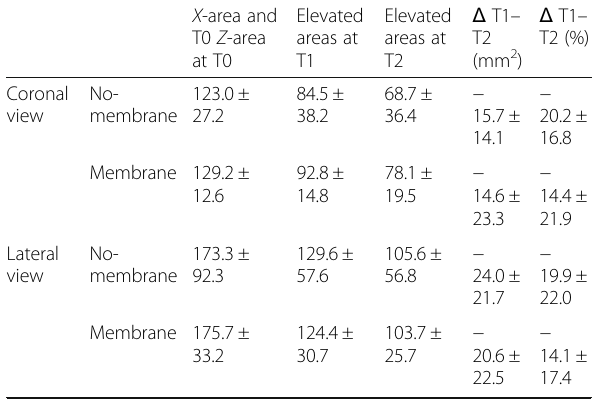
Table 5 Areas (in mm 2 ) in the X and Z planes at the various periods evaluated (T1 = 1 week; T2 = 9 months) and shrinkage in mm 2 and percentages (%) of the elevated space between 1 week and 9 months in the coronal and lateral planes